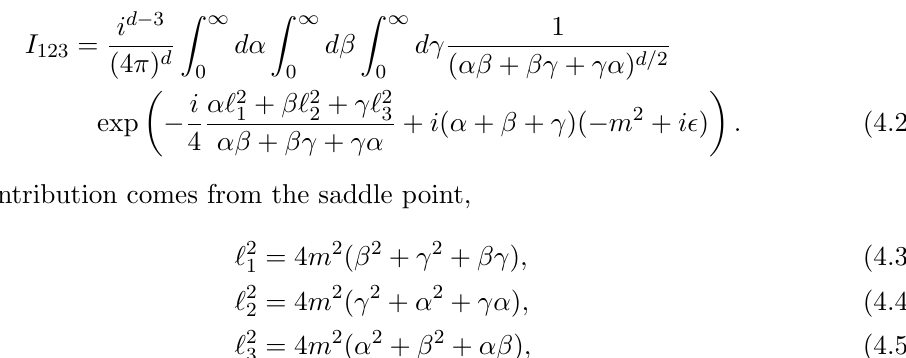
Figure 4. The sides x i (cid:0) x j of the original triangle together with the lines connecting Fermat point with the original points x i form three triangles, each has an obtuse angle of 120 (cid:14) . Using Schwinger parameter representation we can reduce the integral